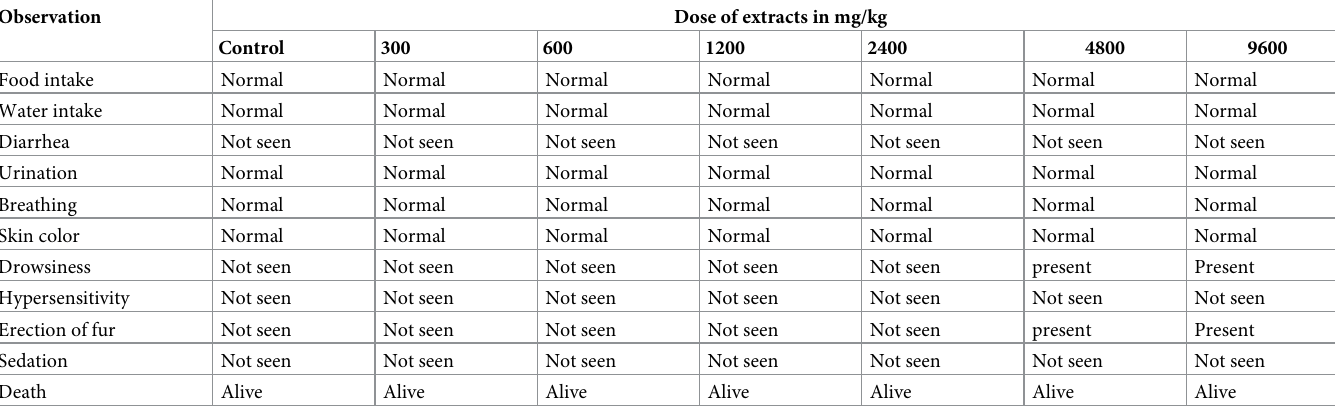
Table 4. General appearance and behavioral observations of acute toxicity study for control and treated groups.